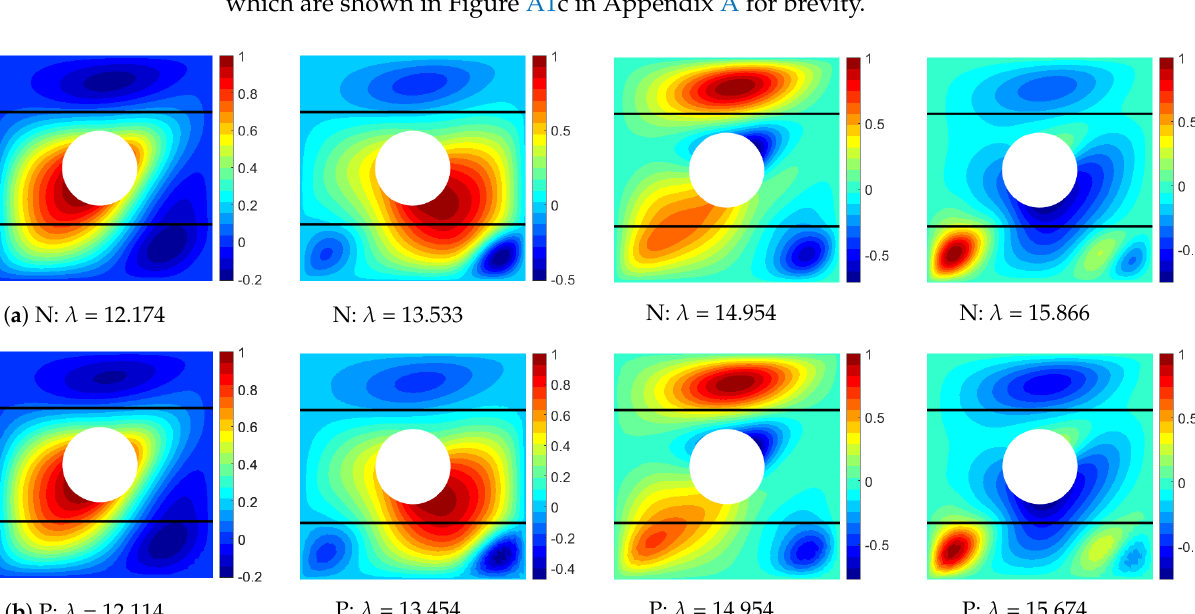
Figure 18. The buckling mode results computed using the present program are in a good agreement with NASTRAN results, as seen in Figure 19. In the buckling mode results, due to the applied symmetric bending displacement about x = a /2, there are many pair modes each of which have the same values of the buckling load factors. Only one of each pair modes is selected for program validation in Figure 19. The stress resultants for the stiffened plate under in-plane pure bending displacements are computed and compared against the NASTRAN results. The two sets of results are found in a good agreement, as seen in Figure 20. The stiffener dominant axial stress distribution is also close to NASTRAN results, which are shown in Figure A1c in Appendix A for brevity.